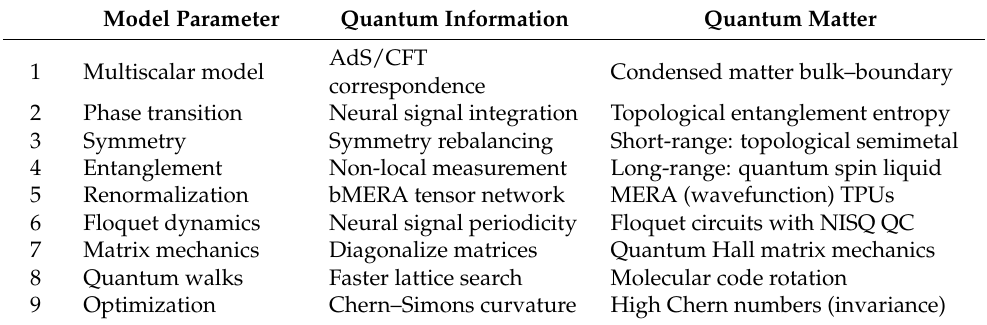
Table 3. Apply Quantum Matter Concepts and Methods to Extend the AdS/Brain